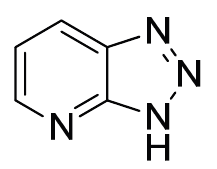
Figure 1. Pyridinyl-1,2,3-triazoles.